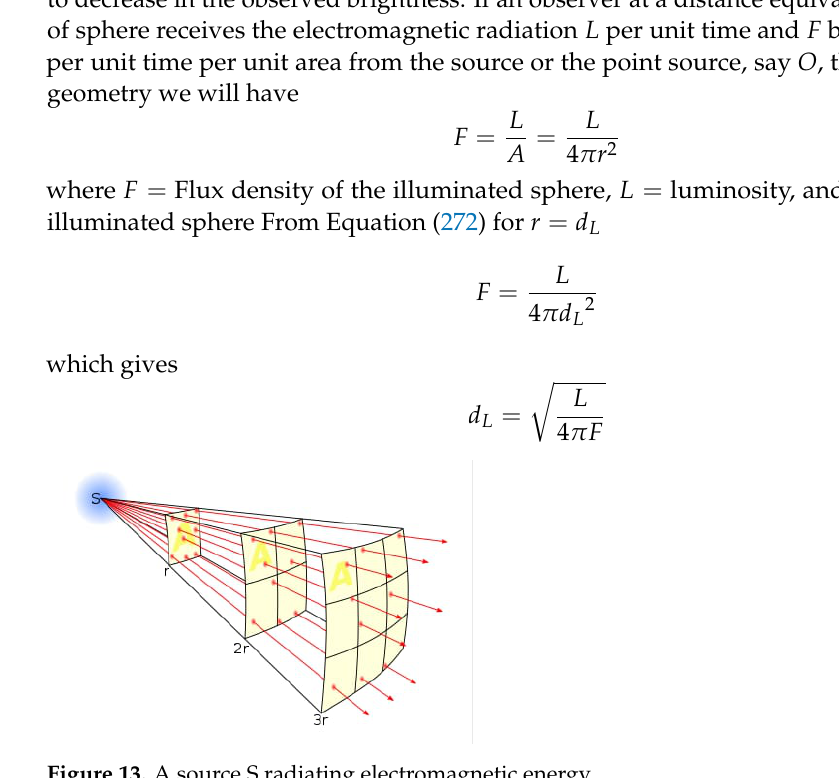
Figure 13. A source S radiating electromagnetic